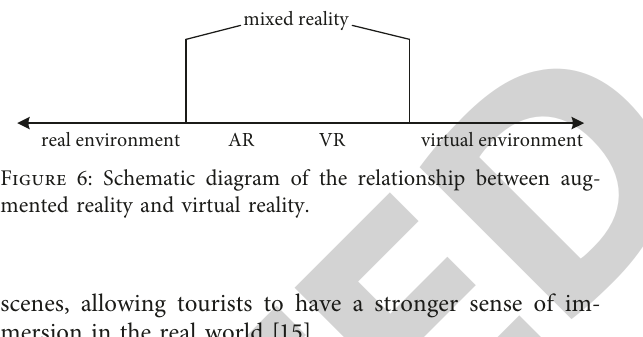
Figure 5: Definition of equiprobability confidence.